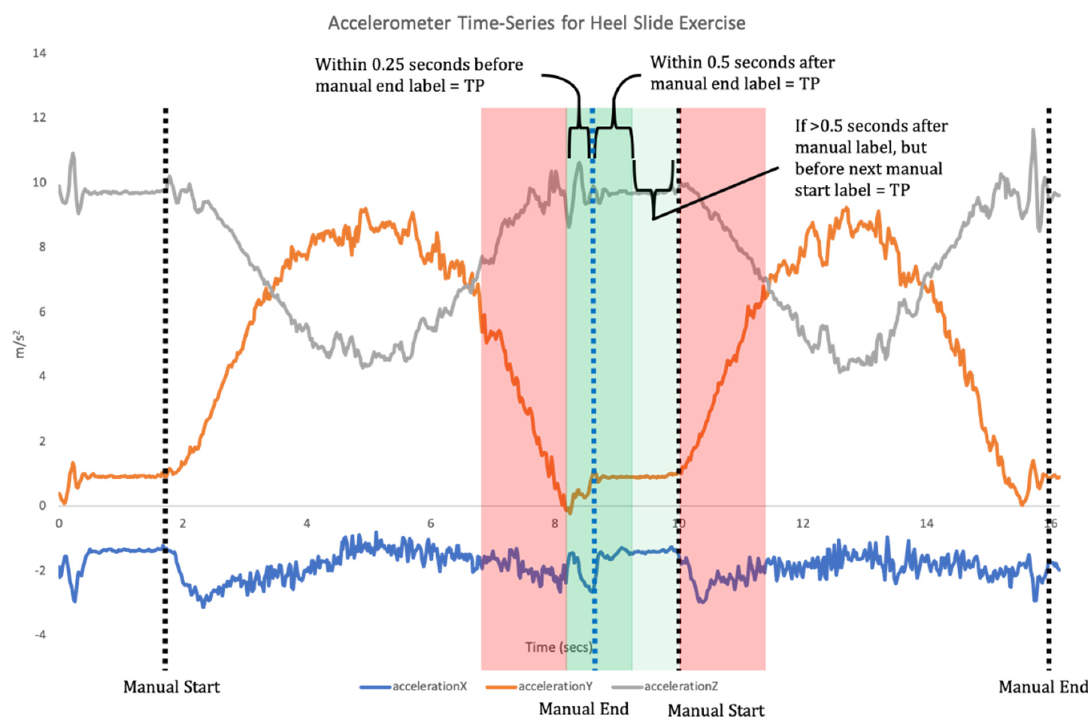
Figure 6. Illustration of threshold for segmentation for points identified as the end of a repetition. The manual annotation for reference is highlighted in blue and area for TP in green.